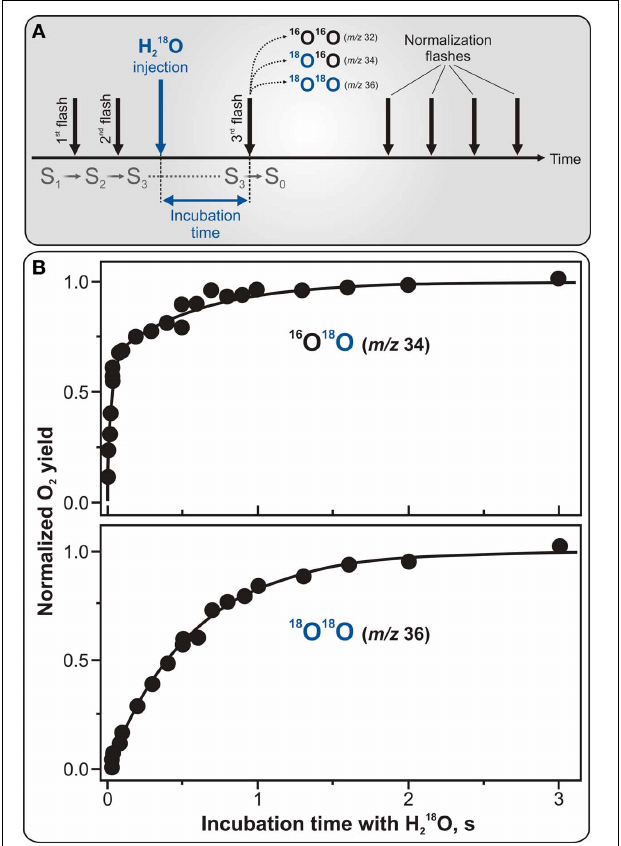
FIGURE 4 | Protocol for TR-MIMS measurements of H 16 2 O/H 18 2 O exchange in the S 3 state of PSII (A) and experimentally obtained substratewaterexchangeratesinspinachthylakoids(B).(A) TheS 3 state is populated by two pre-flashes given at 2Hz (shown by the two first black vertical arrows). This is followed by the rapid injection of H 18 2 O into the PSII sample (shown by blue vertical arrow) and subsequent fast mixing of the injectedH 18 2 Owiththesample.EvolutionofO 2 isotopologuesistheninduced by a 3rd flash, given at varying delay times (from 0 to 10s) after the H 18 2 O injection (signified as incubation time). Finally, a series of four flashes is given at 2Hz to induce O 2 yield used for normalization. (B) TR-MIMS measurements of substrate H 16 2 O/H 18 2 O exchange kinetics were performed at m/z 34 (top plot) for singly-labeled isotopologue 16 O 18 O, and at m/z 36 (bottomplot)fordoubly-labeled 18 O 18 OintheS 3 stateinspinachthylakoidsat 10 ◦ CandpH6.8.Symbolsinbothplotsareexperimentaldata,andthelinesin the top and bottom plots are biexponential and monoexponential fits, respectively.Thebiexponentialfityieldsrateconstantsof ∼ 40s − 1 forthefast phase and ∼ 2s − 1 for the slow phase. The slow phase in the 16 O 18 O data is matching the rate found in the monoexponential fit of the 18 O 18 O